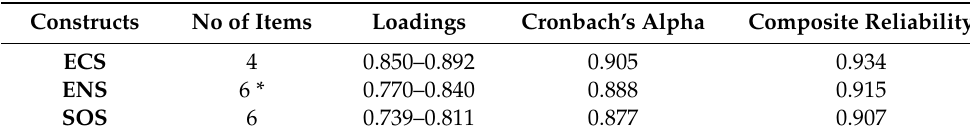
Table 3. Internal consistency reliability.